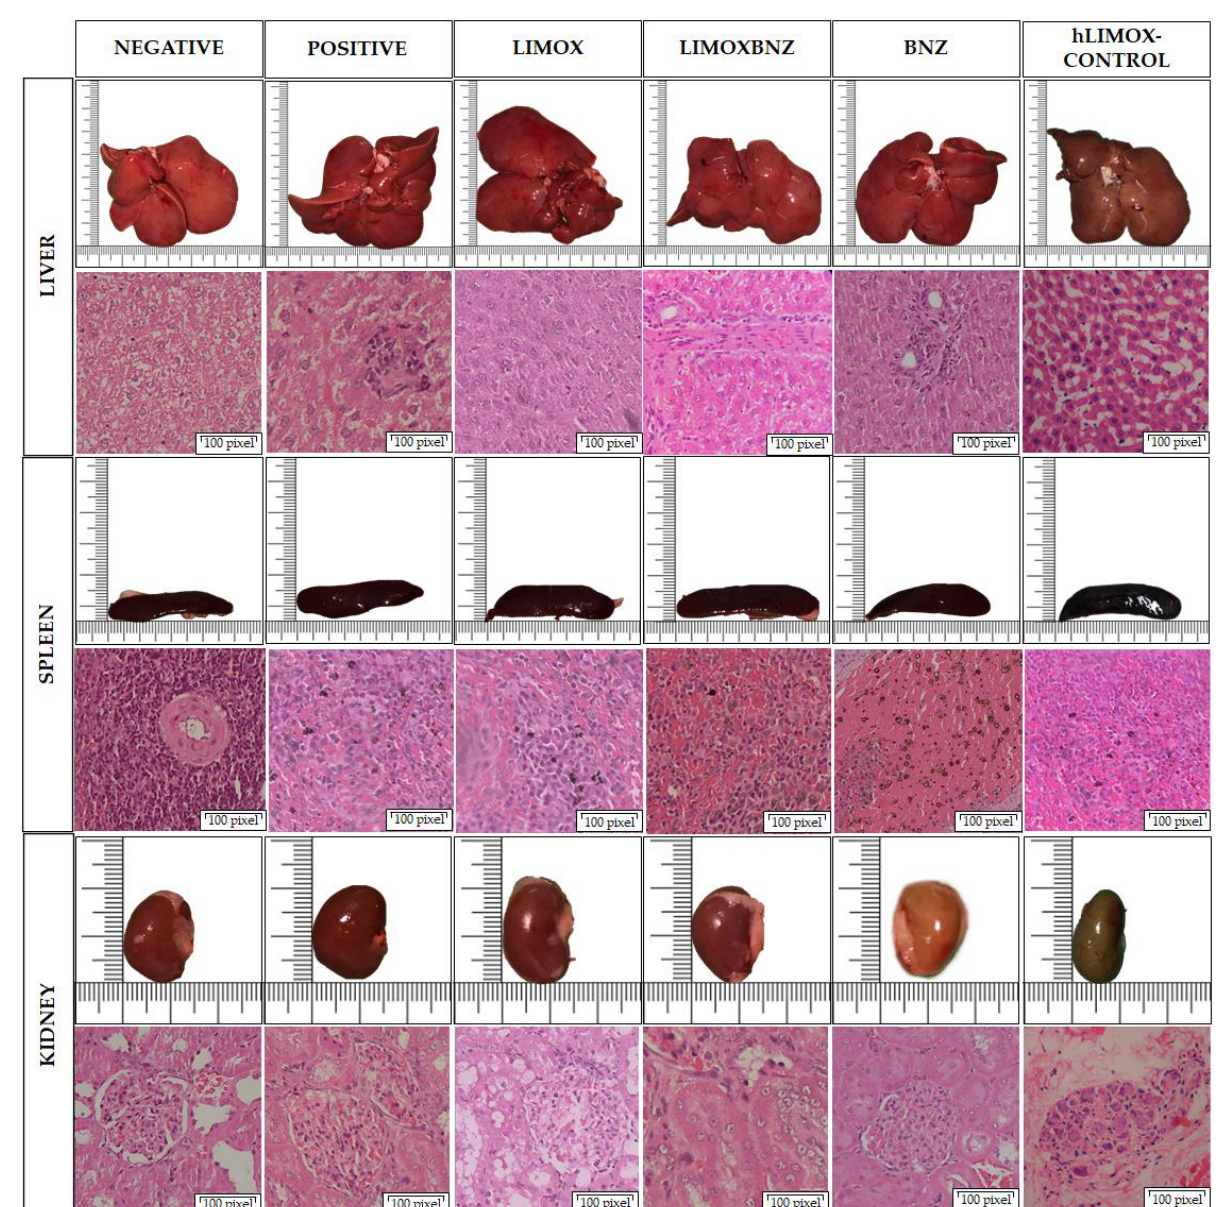
Figure 4. Organ toxicity assessment. Histological images taken using a 40 × objective on Hematoxylin and Eosin stained tissue sections. Negative control: untreated, uninfected animals; hLIMOX-Control: not infected animals treated with higher doses of an essential oil fraction of Lippia alba carvone chemotype enriched in limonene (170 mg/kg/day) and with added caryophyllene oxide (Sigma-Aldrich) (70 mg/kg/day); Positive control: untreated, infected animals; LIMOX: infected animals treated with a mixture of an essential oil fraction of Lippia alba carvone chemotype (enriched in limonene) (68.9 mg/kg/day) and with added caryophyllene oxide (Sigma-Aldrich) (70 mg/kg/day); LIMOXBNZ: infected animals treated with LIMOX plus benznidazole (7.9 mg/kg/day); BNZ: infected animals treated with benznidazole (100 mg/kg/day). Figures are representative of six independent